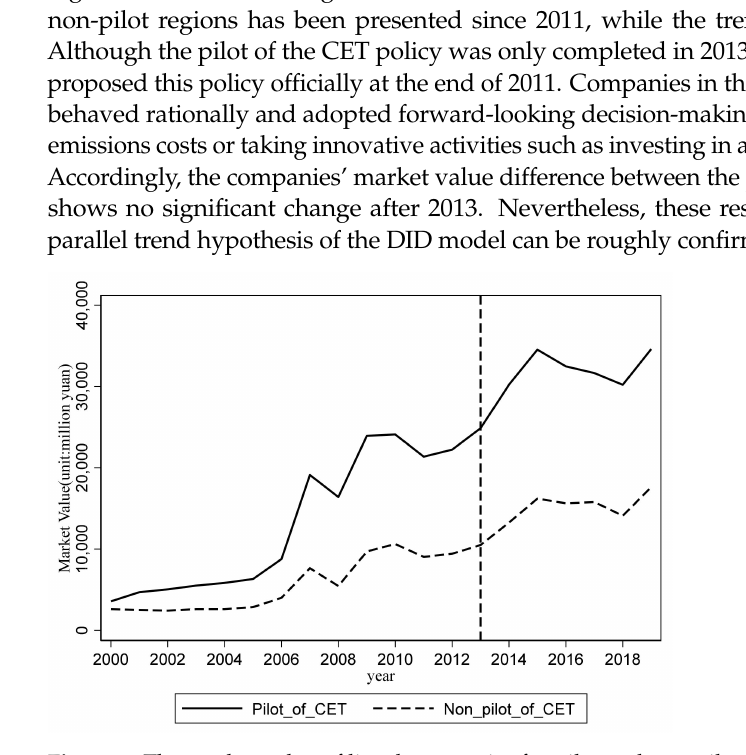
Figure 1. The market value of listed companies for pilot and non-pilot regions of